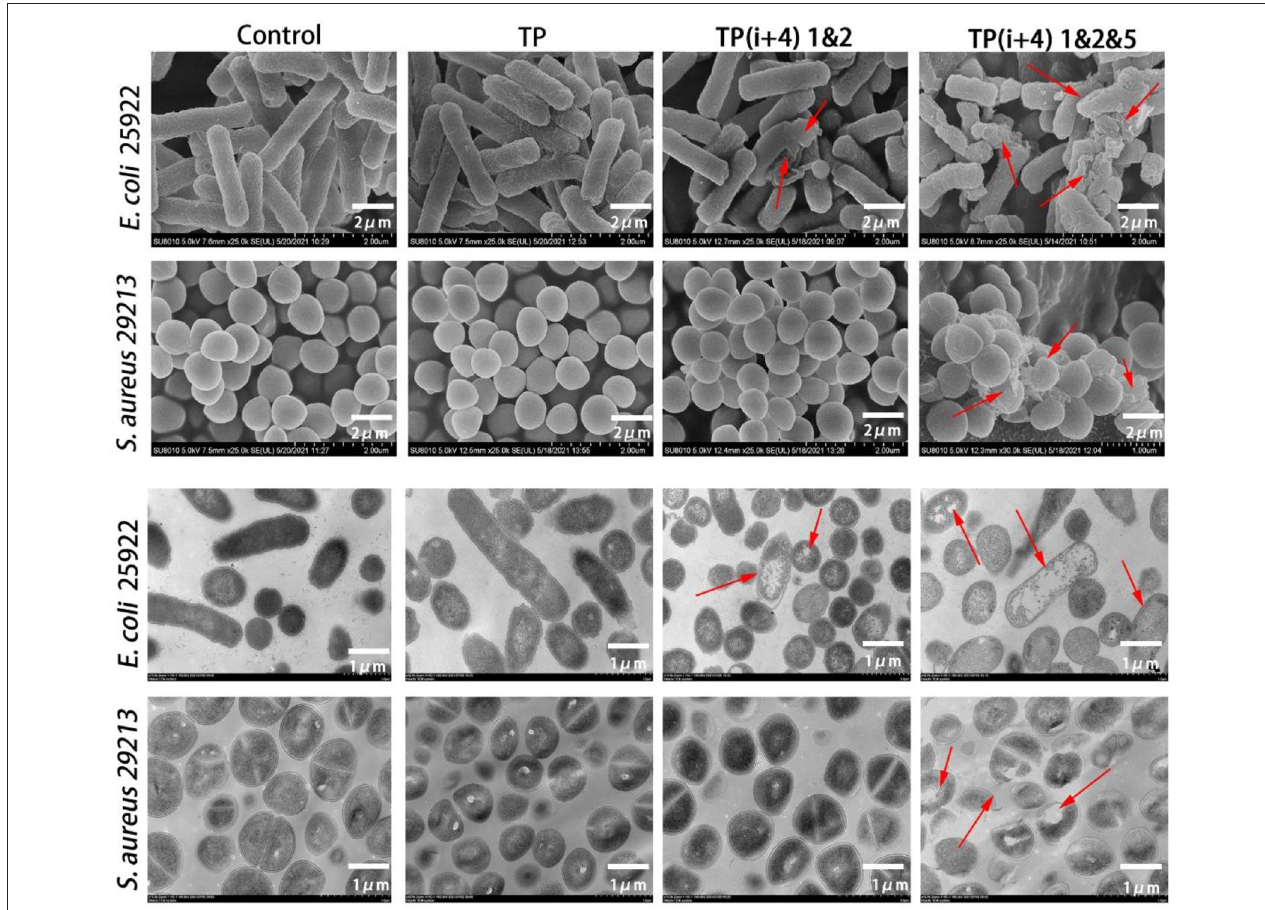
FIGURE 5 | SEM and TEM micrographs of E. coli 25922 and S. aureus 29213 treated with TP , TP(i + 4) 1&2 and TP(i + 4) 1&2&5 for 60min. SEM: the scale bar is 2 µ m. TEM: the scale bar is 1 µ m. The red arrows point to areas of obvious damage to the bacterial